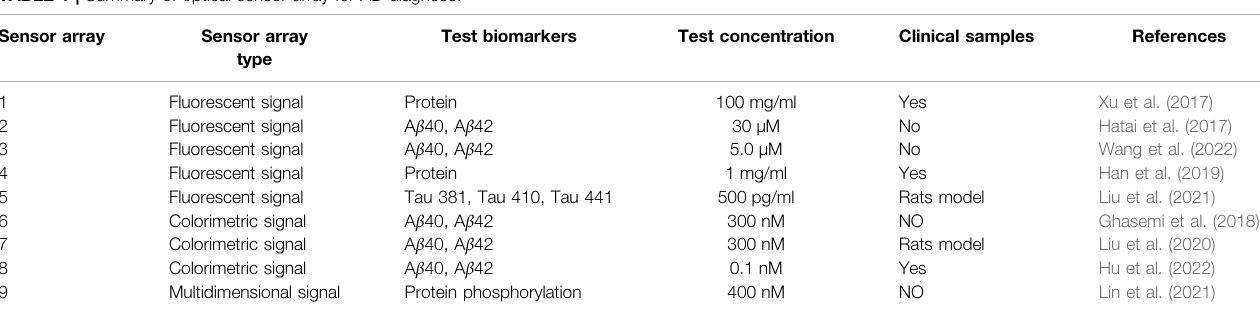
TABLE 1 | Summary of optical sensor array for AD diagnose.